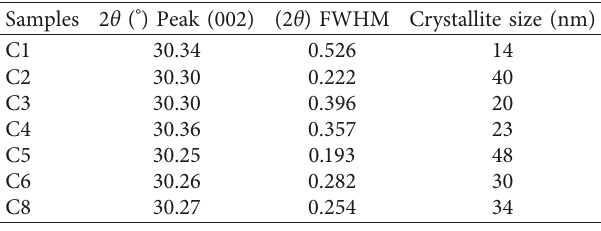
Table 2: Size of the crystallite obtained in accordance with to the Scherrer equation, using the (002) diffraction plane of hydroxiapatite.